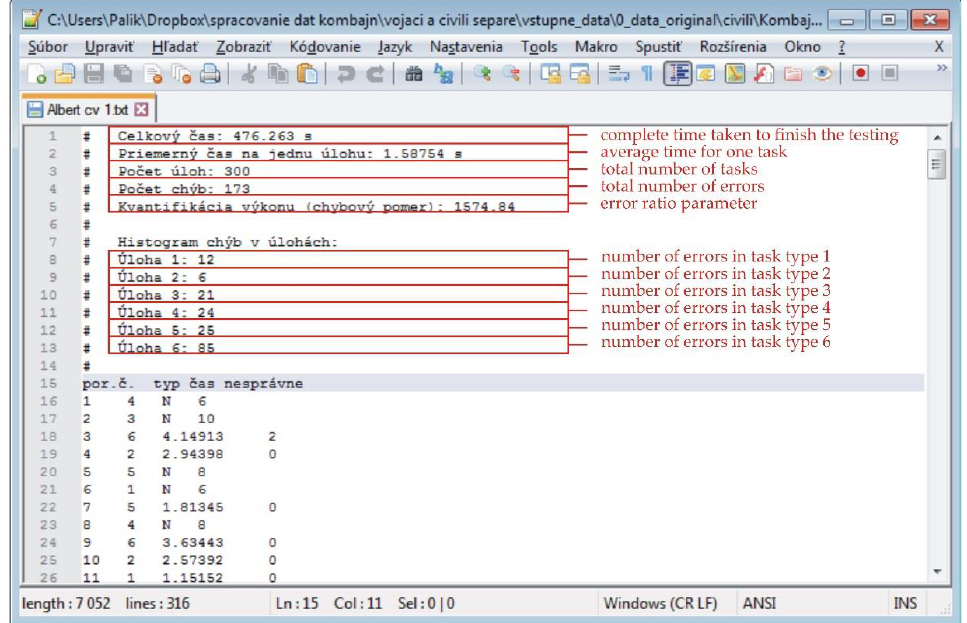
Figure 7. Output file